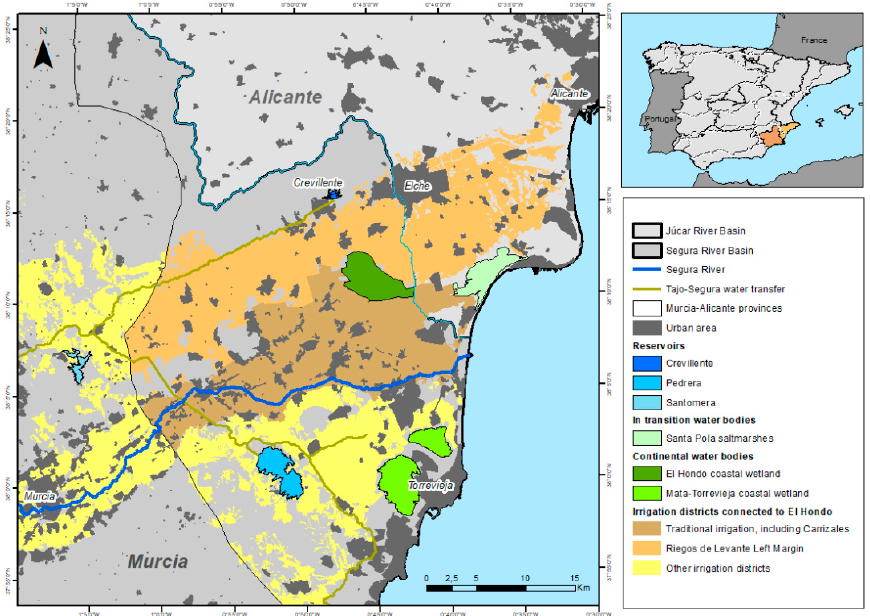
Figure 1. Location of El Hondo and Santa Pola CWs and the area irrigated by Riegos de Levante and Carrizales irrigation communities. Source: adapted from [56].